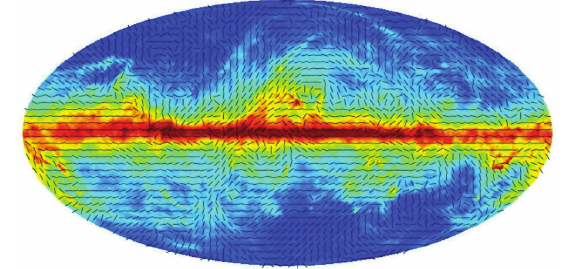
Figure 2. All-sky map in Galactic coordinates (with the Galactic center in the middle) of the total intensity of the 353GHz dust thermal emission measured by Planck [15]. The small bars show the polarization half-vectors rotated by 90 ◦ to trace the orienta- (cid:3) B tion of ⊥ .